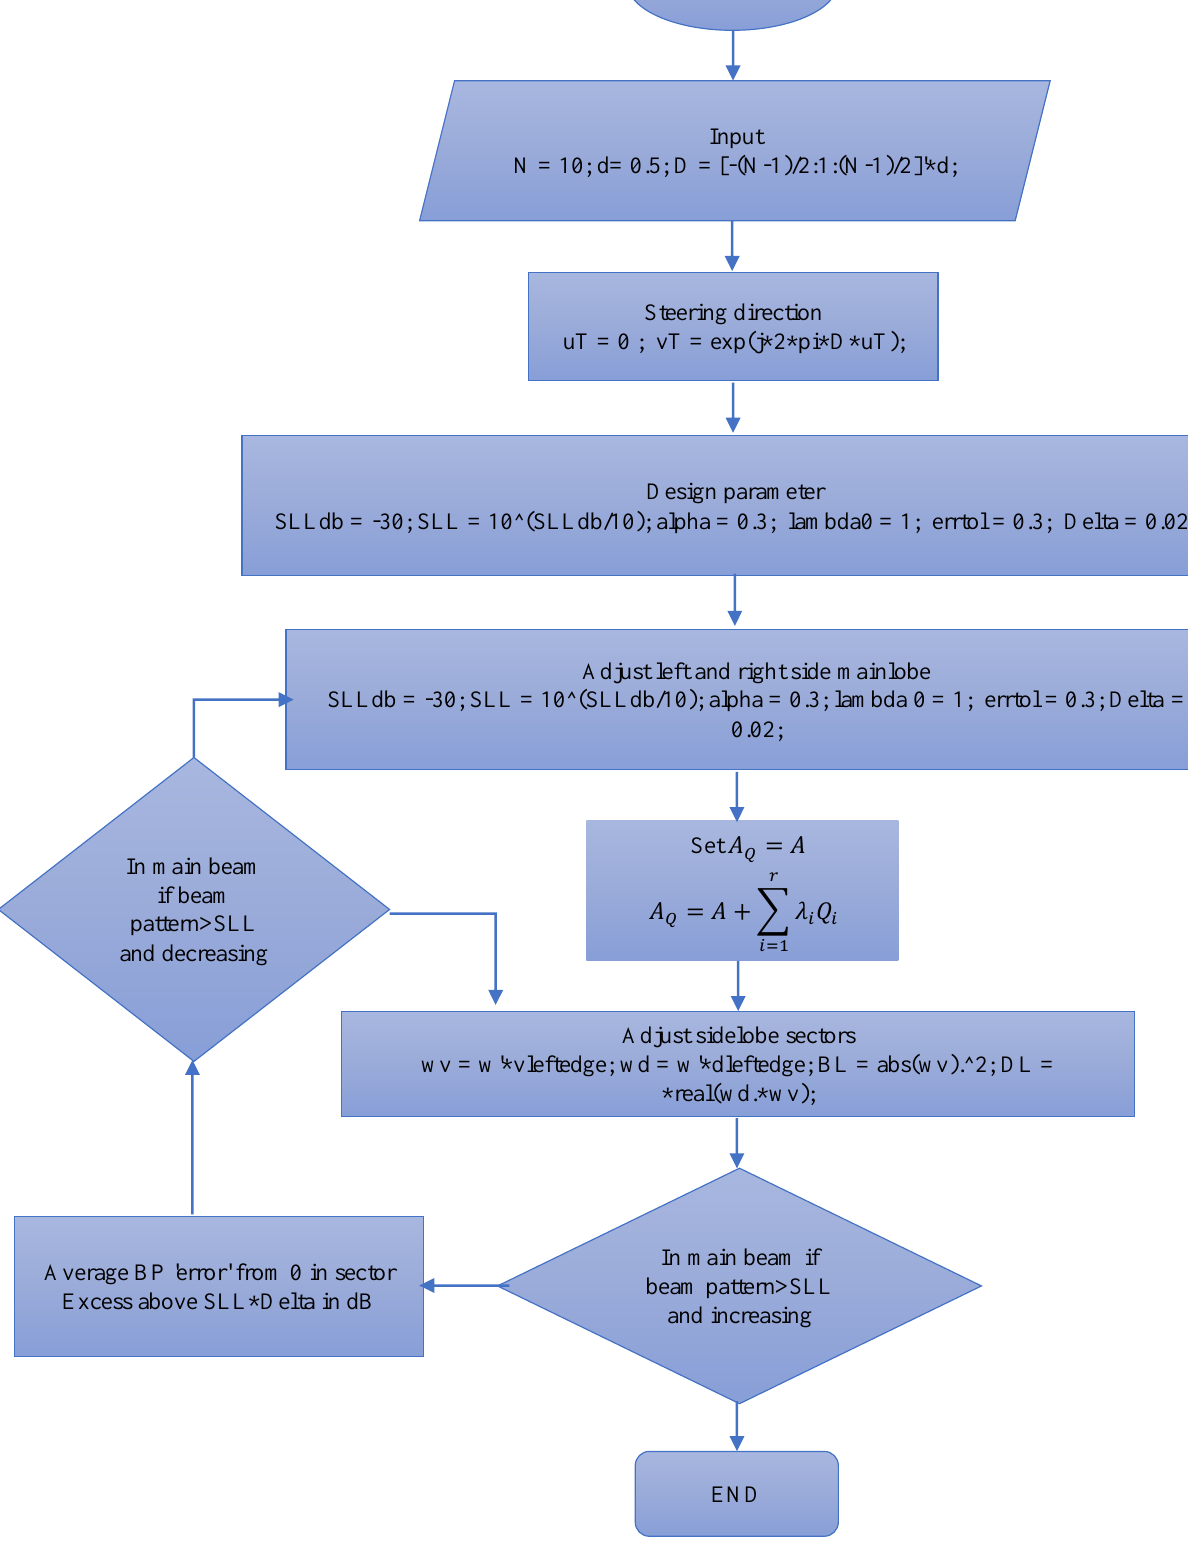
Figure 1. The iterative sidelobe level (SLL) reduction procedure is depicted as a flowchart. 2- Minimum Redundant Linear Arrays and Uniform Linear Arrays Model This section describes the antenna array models by considering MRLAs and ULAs